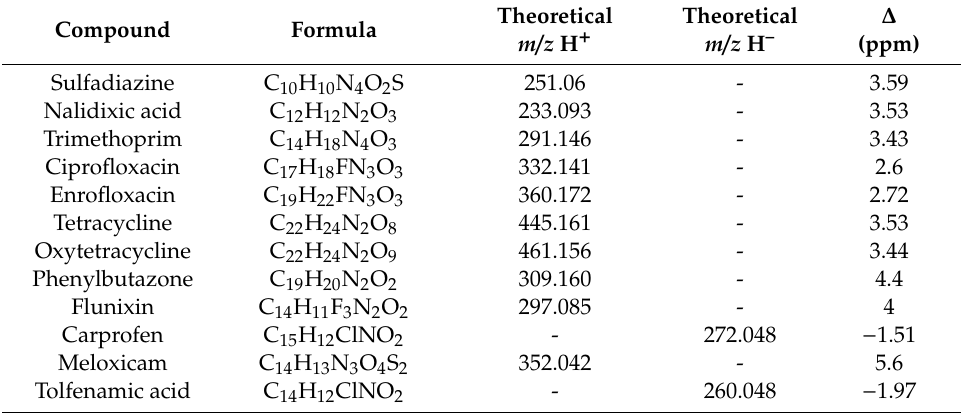
Table 1. List of compounds analyzed and their corresponding data (molecular formula, theoretical masses of their adducts) for identification in the HPLC-MS-TOF analysis in plasma samples. Compound Formula